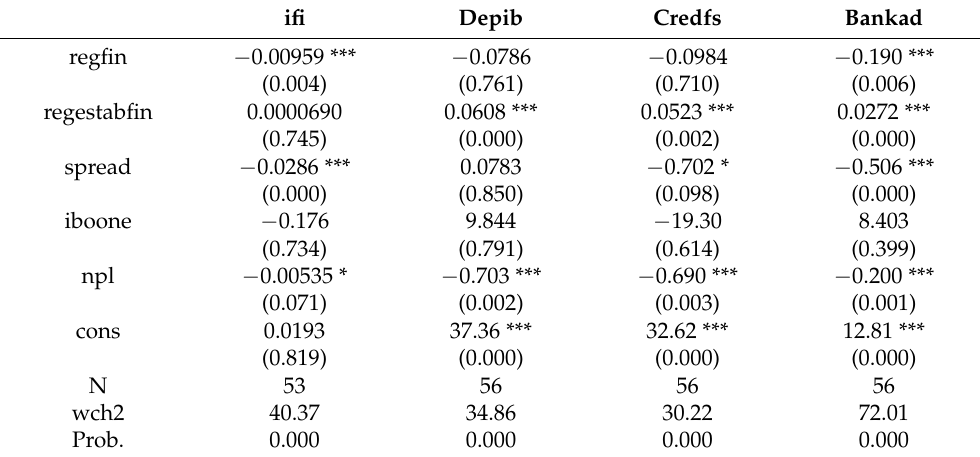
Table 7. SAARC countries’